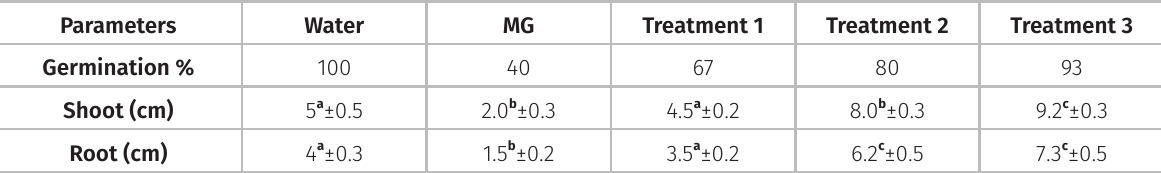
Table I. Germination percentage, shoot and root lengths of V. radiate seedlings treated with water effluents produced after MG removal using different biosorbent treatments*.